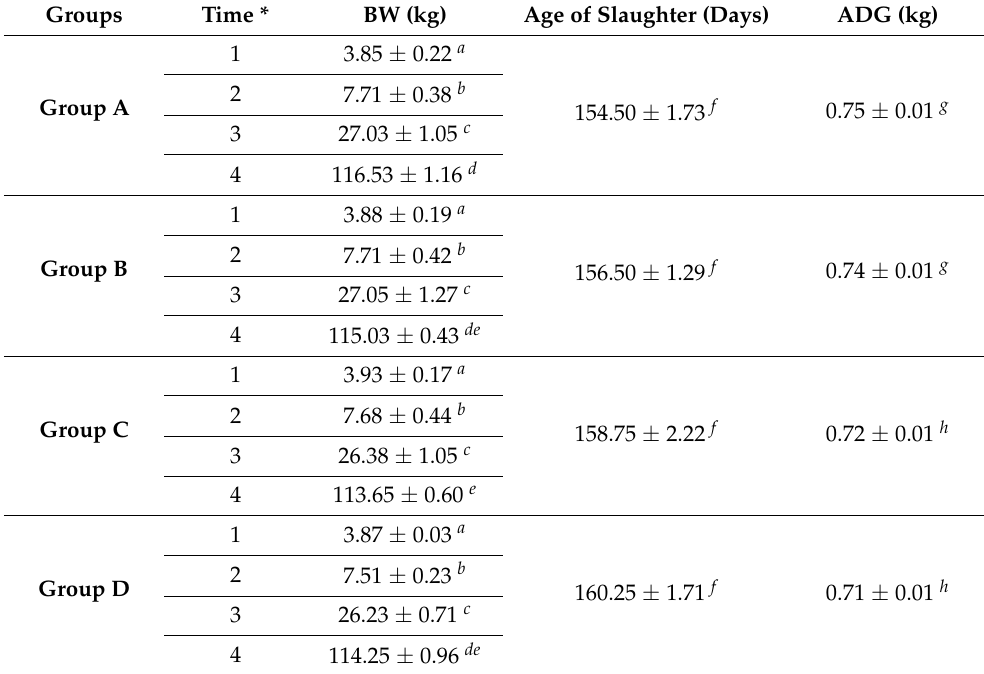
Table 4. Performance parameters (BW, age of slaughter, ADG) (mean ± SD).